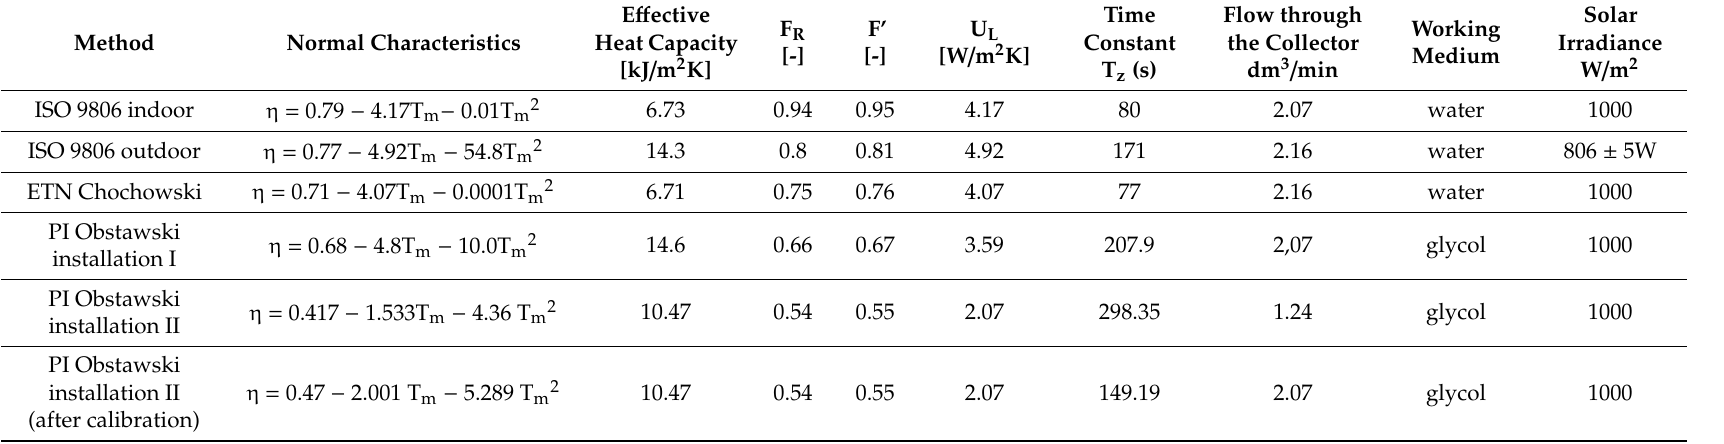
Table 3. Comparison of the characteristic parameters of collectors based on di ff erent